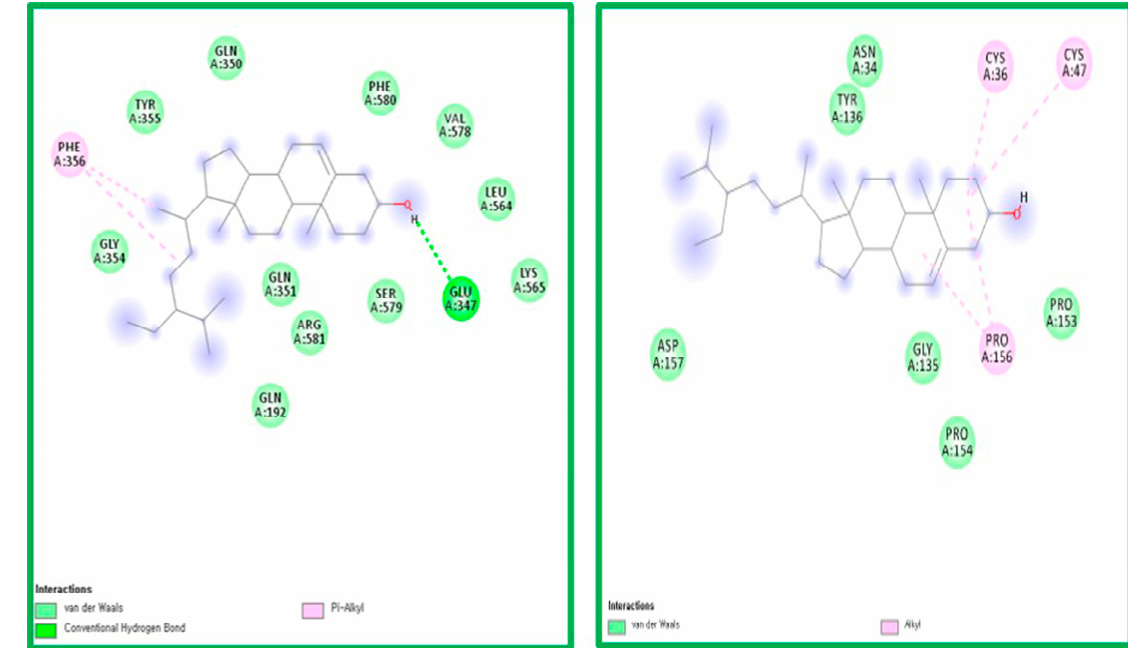
Figure 5. The ligand-receptor interaction screening of BS- COX-1 and